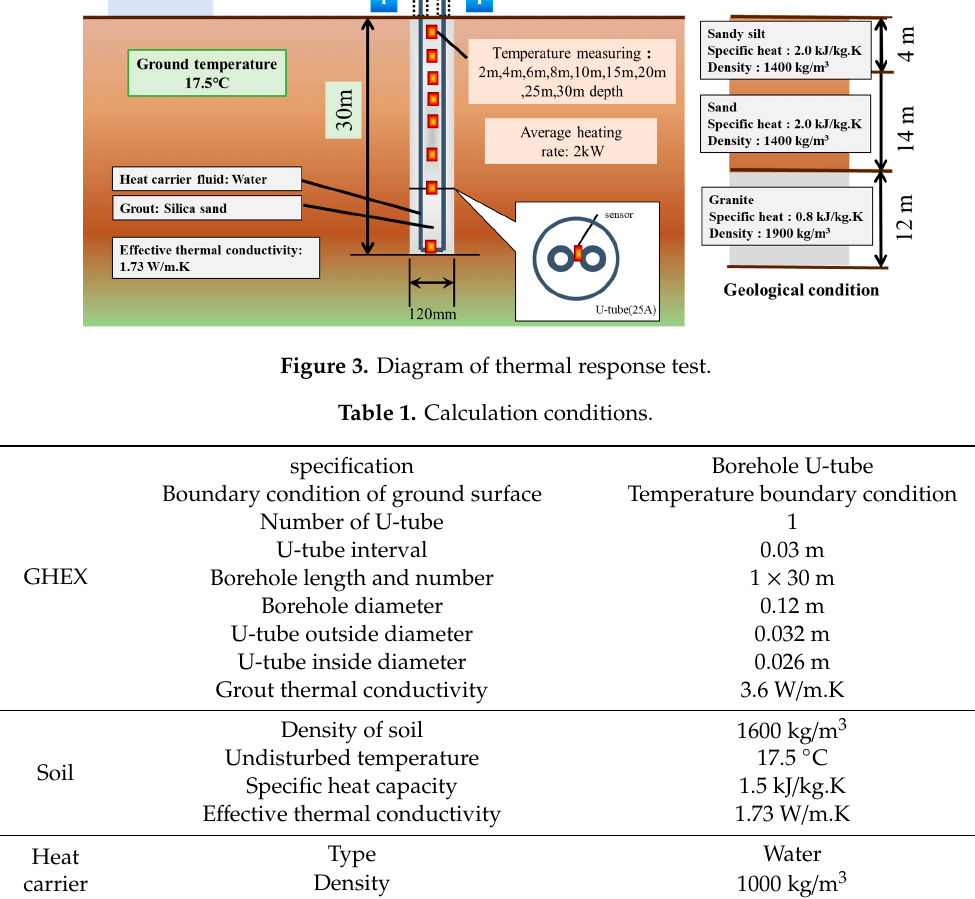
Table 1. Calculation conditions.